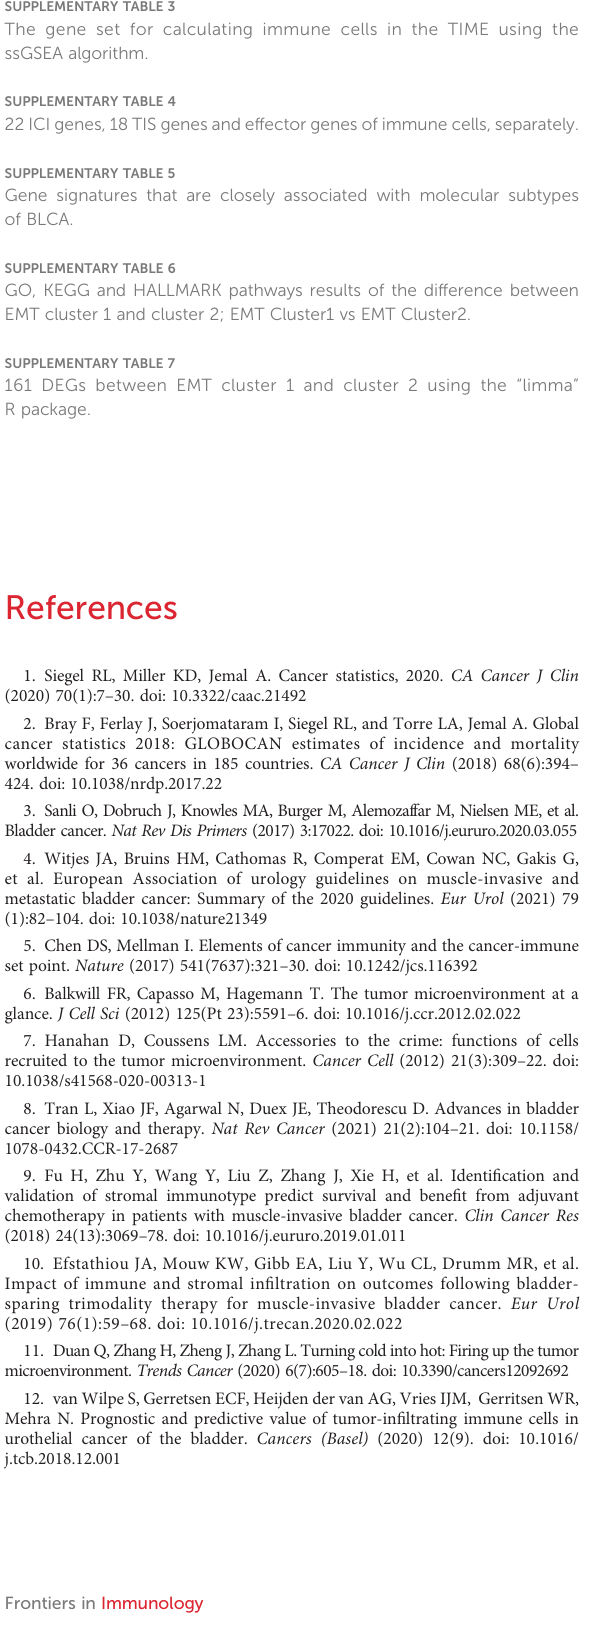
SUPPLEMENTARY TABLE 10 The association between EMT risk score and cancer immunity cycles in Xiangya cohort.